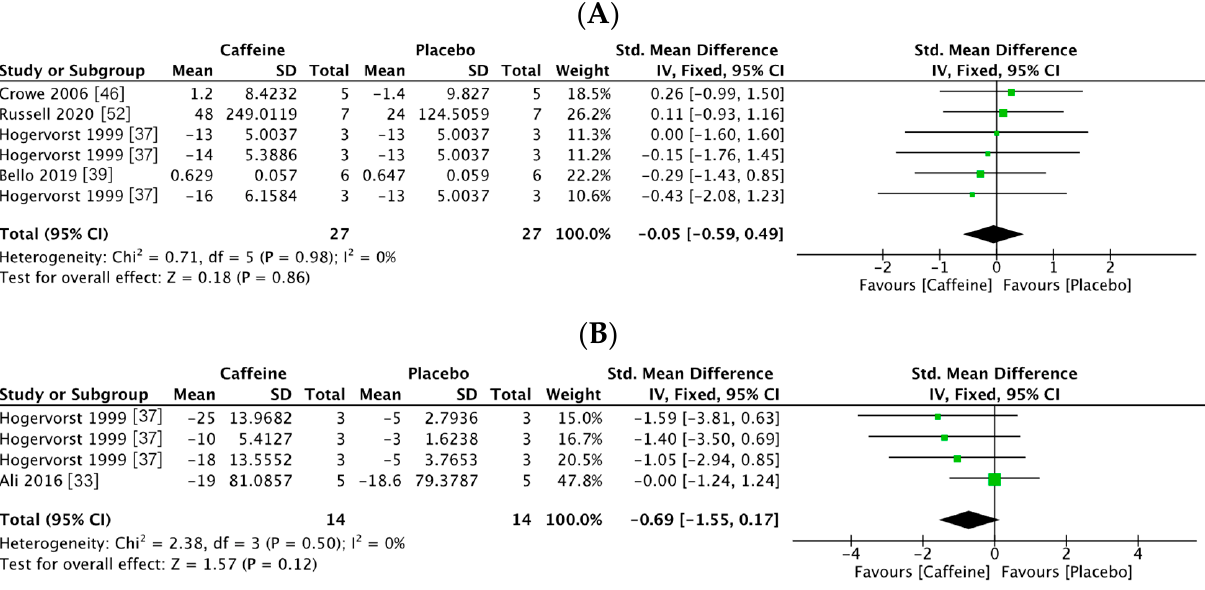
Figure 3. Forest plots of reaction times observed in the athletes in conditions of supplementation with caffeine vs. a placebo. ( A ) Simple reaction time; ( B ) choice reaction time.